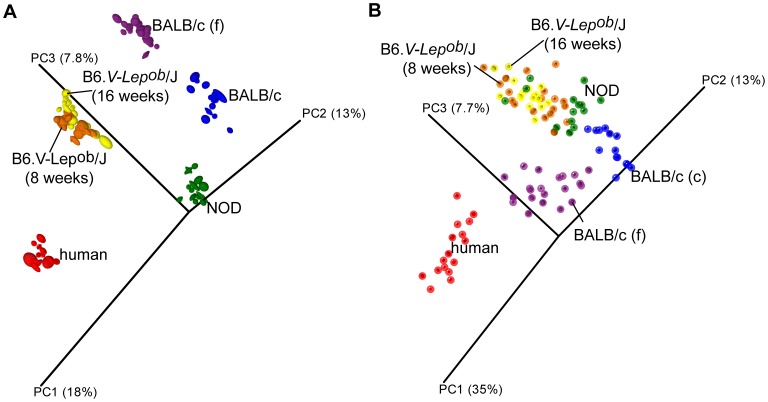
PCoA plot based on (A) unweighted and (B) weighted distance matrices, each calculated from 10 rarefied (4500 reads per sample) OTU tables.A) Qualitative information used to generate principal coordinates enables for clear clustering according to host that samples were collected from. B) Quantitative information used to generate principal coordinates enables for clear separation of human and both BALB/c samples and less distinct but significant (Table 2) separation of the NOD and two B6 mice GM profiles. Labels “BALB/c (f)” and “BALB/c (c)” stand for the gut GM of BALB/c mice determined using fecal and caecal samples respectively. The degree of variation between 10 jackknifed replicates of PCoA is displayed with confidence ellipsoids around each sample.